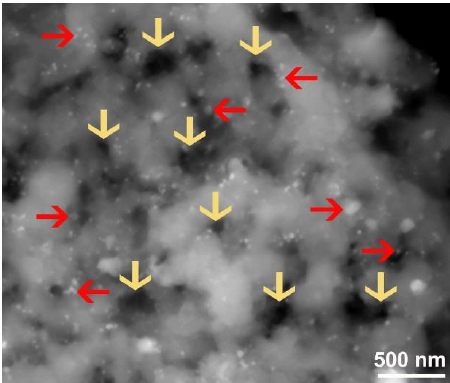
Figure 13. FE-SEM micrograph of nanocomposite MgH 2 /7 wt% a-LaNi 3 powders obtained after subjected to cycle-life-time of 2000 h. The arrows in yellow indexed in the figure denote to the artificial pores formed at the outermost shell of Mg aggregated powders upon penetration of a-LaNi 3 nanoparticles (indexed by red arrows) during the cyclic test. The red arrows refer to a-LaNi 3 powders.